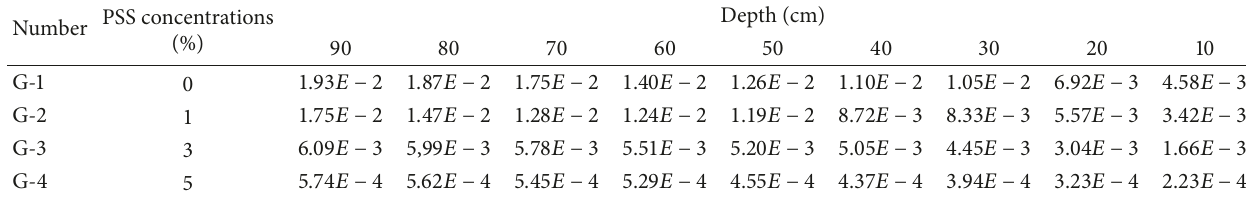
Table 6: The permeability coefficient of specimens with different depth (cm/s).